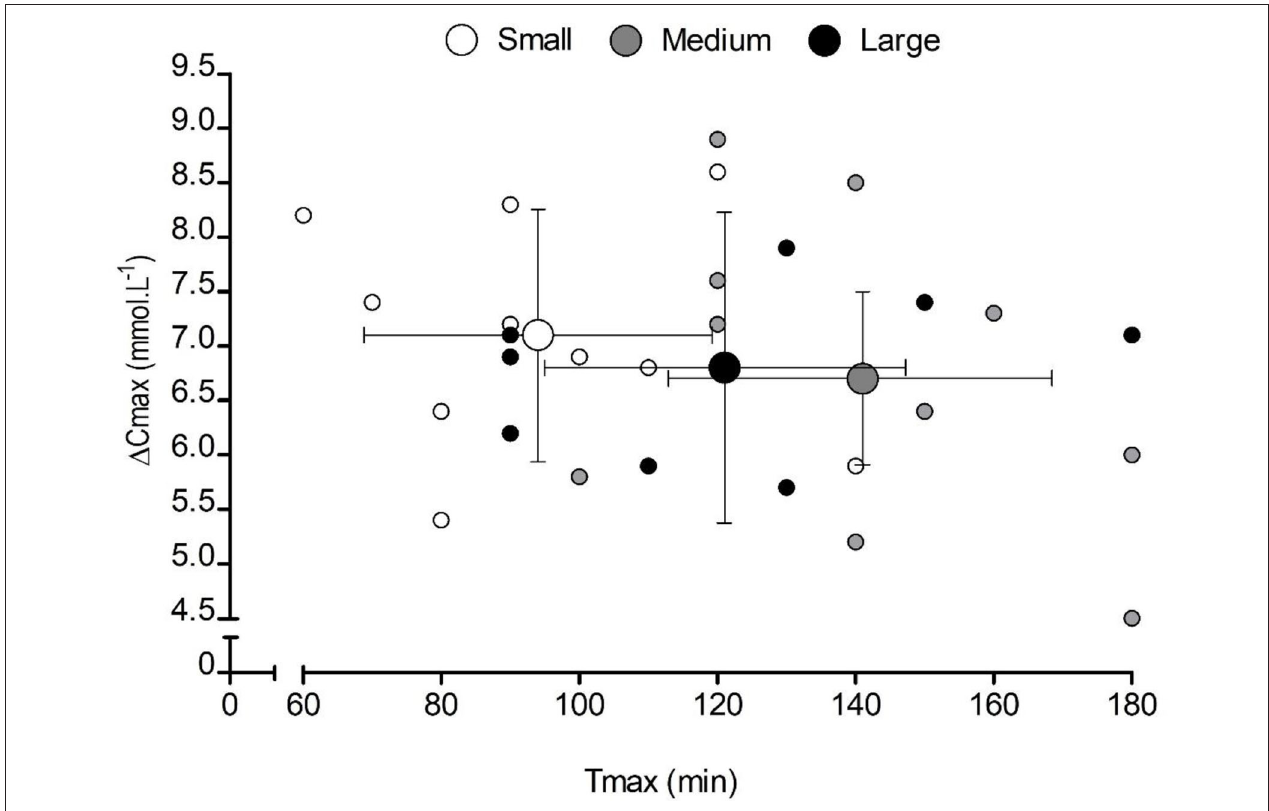
FIGURE 2 | Mean ( ± SD) and individual peak changes in blood bicarbonate concentration [HCO − 3 ] ( 1 C max ) following the consumption of 0.3 g · kg − 1 body mass NaHCO 3 in small-, medium-, and large-sized capsules. Small markers represent individual responses, and large markers represent the mean data for each capsule condition. The X and Y whiskers represent the SD of the sample in each condition for time-to-peak [HCO − 3 ] ( T max and 1 C max , respectively).